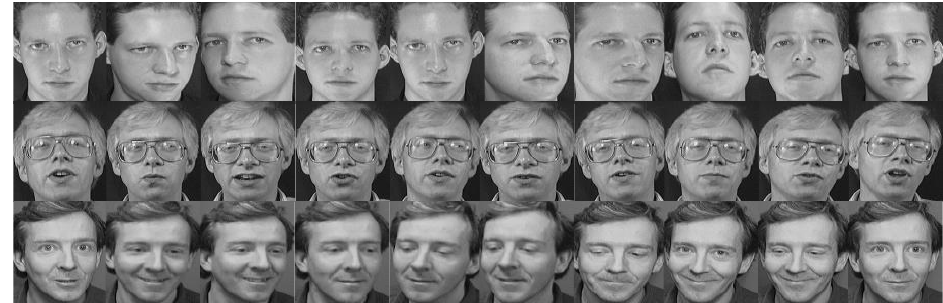
Figure 3. Examples of three subjects from the ORL face database.